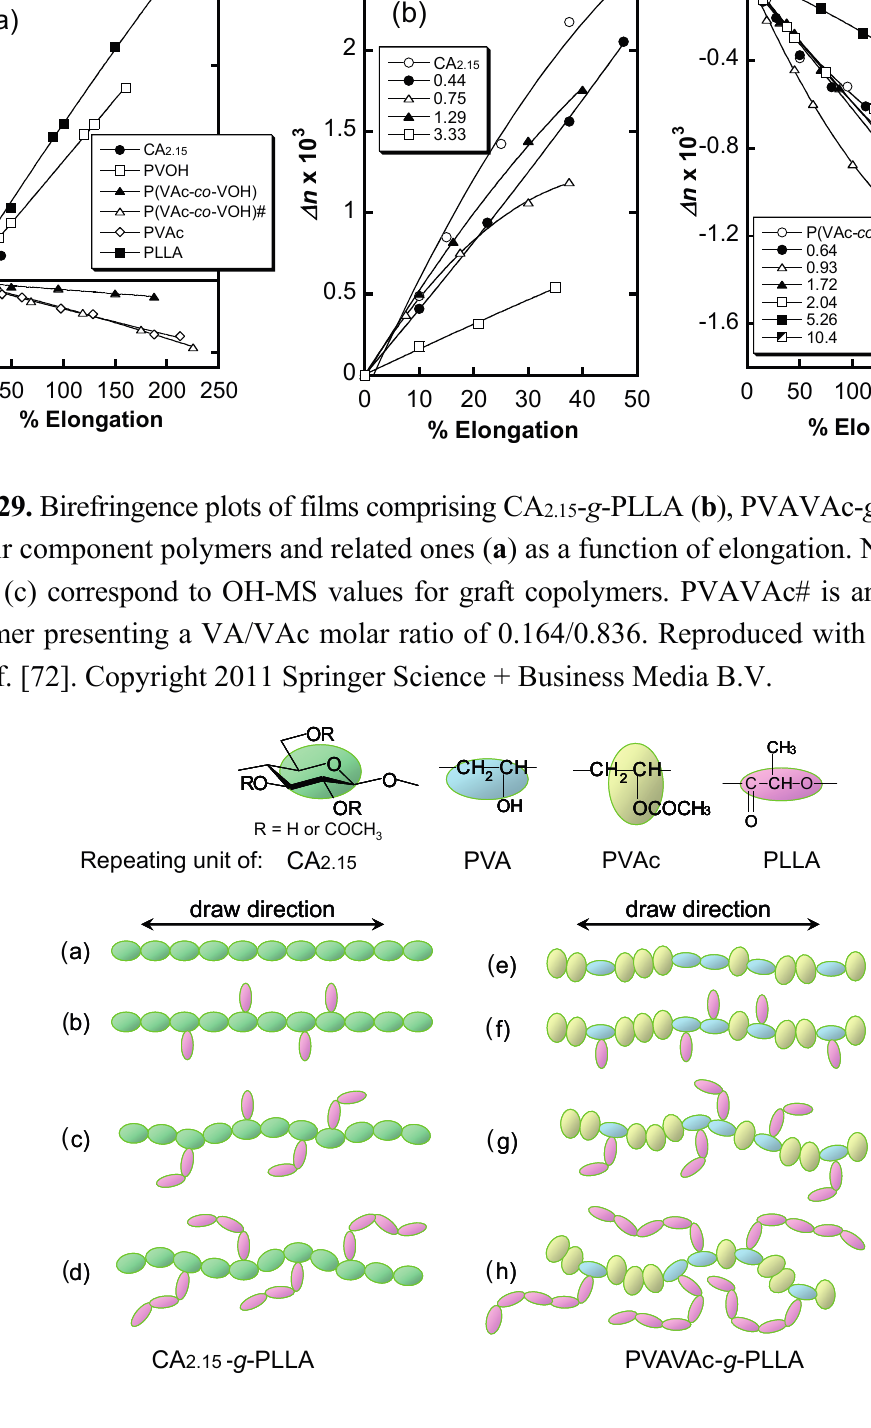
Figure 30. Schematic representation of orientational birefringence in CA 2.15 - g -PLLA ( a – d ) and PVAVAc- g -PLLA ( e – h ). Polymeric chains appear as polarizability ellipsoid sequences of the constituent monomeric units. Reproduced with permission from ref. [72]. Copyright 2011 Springer Science + Business Media